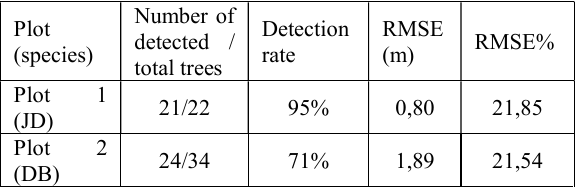
Table 1. Statistics of the measured and estimated crown